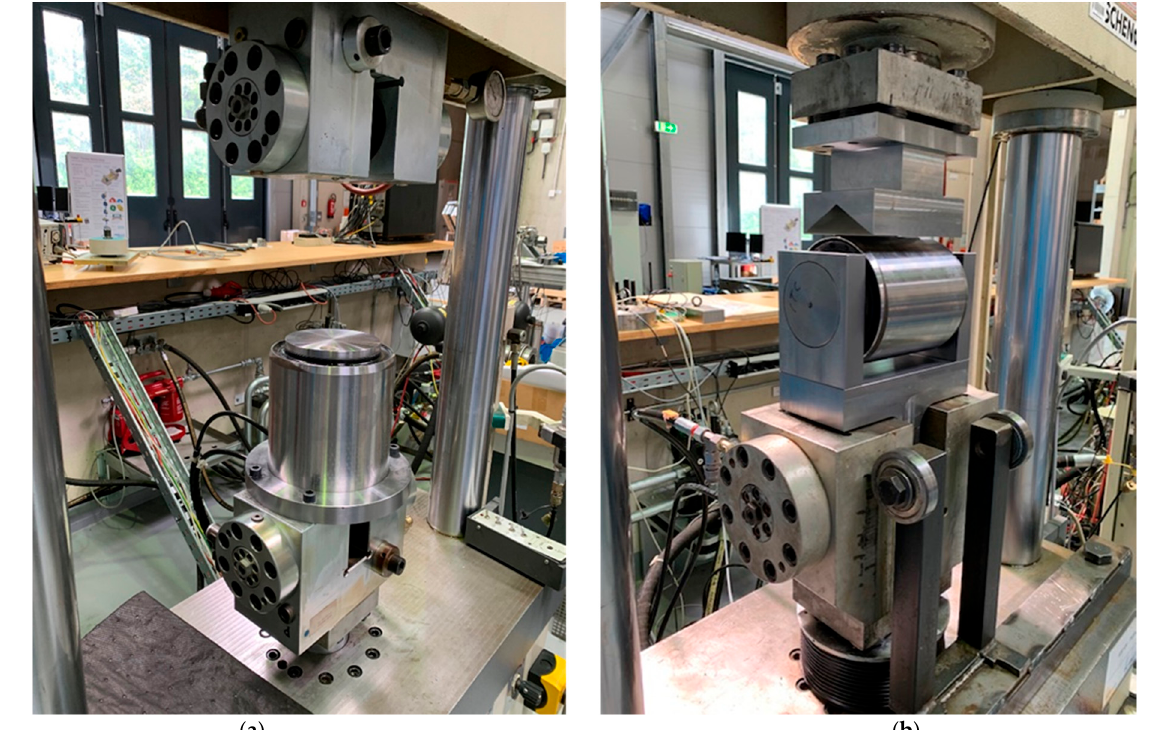
Figure 3. Bushing tests for stiffness estimation in the axial ( a ) and radial ( b ) directions.